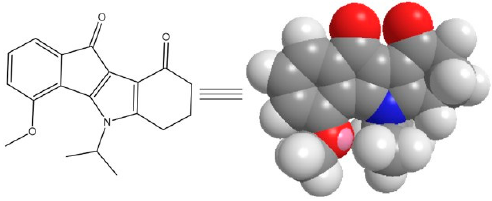
Figure 1. Structure of THN7 derivative.